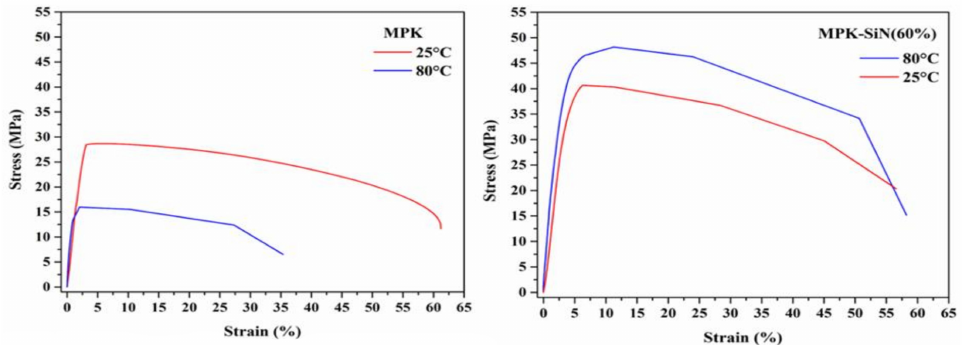
Figure 6. The stress–strain curve of modified polyketone (MPK) and MPK-SiN (60%) at 25 ◦ C and 80 ◦ C.